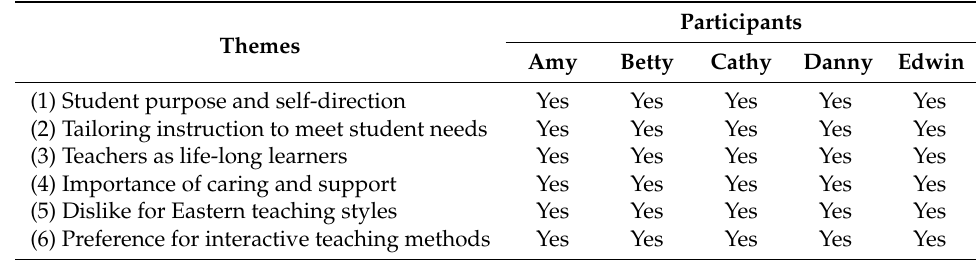
Table 2. Themes of the research